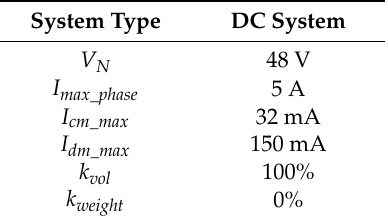
Table 1. Input data for the rule-based algorithm–case study #1.